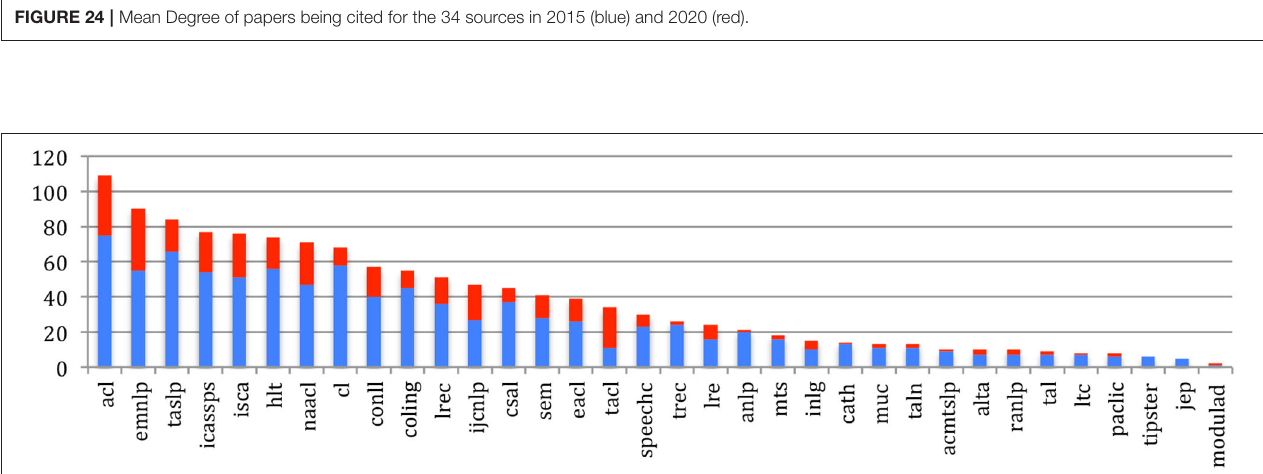
FIGURE 25 | Internal h-index of the 34 sources in 2015 (blue) and 2020 (red).